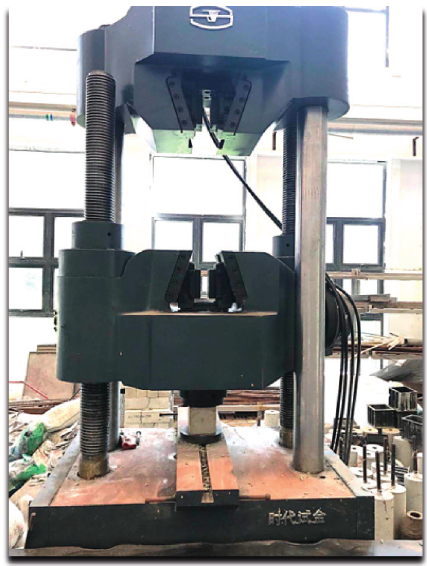
Figure 3: Compressive strength test equipment.